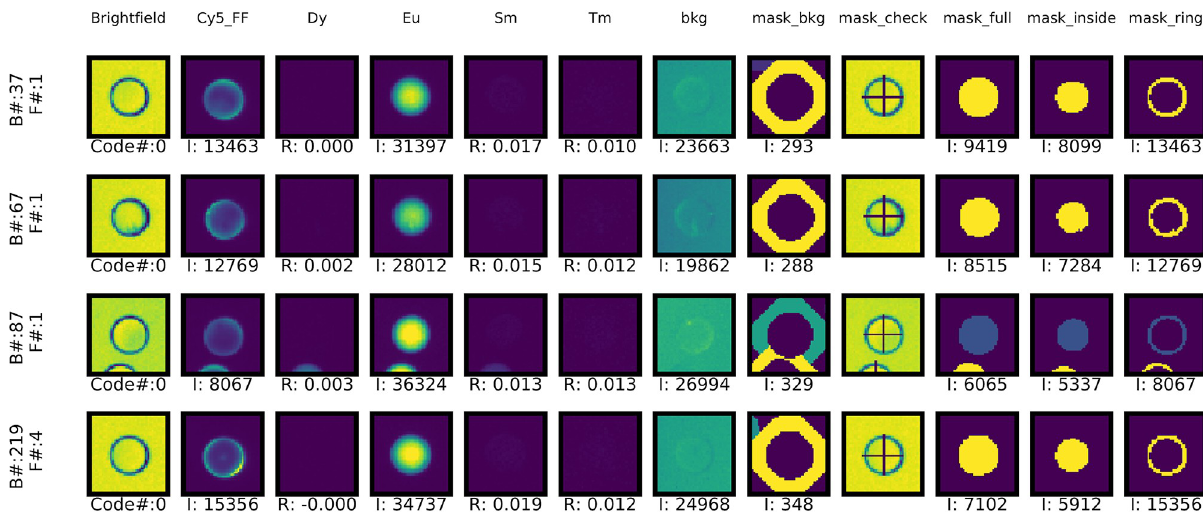
Fig 7. Example per-MRBLE image report. F = File number, I = Intensity in set region, and R = ratio.